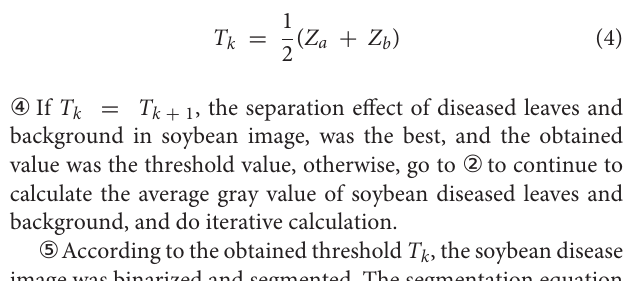
selection of threshold value in the method will directly